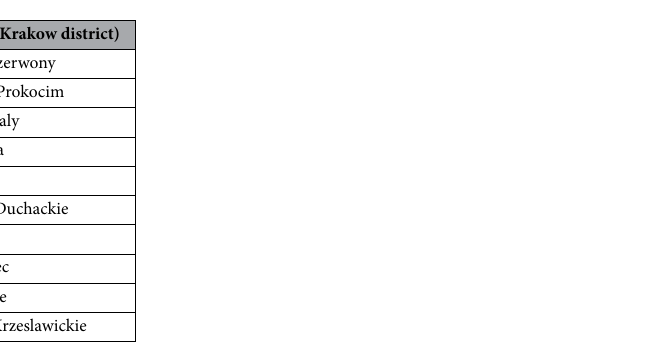
Table 1. Sensor location (district) and elevation in